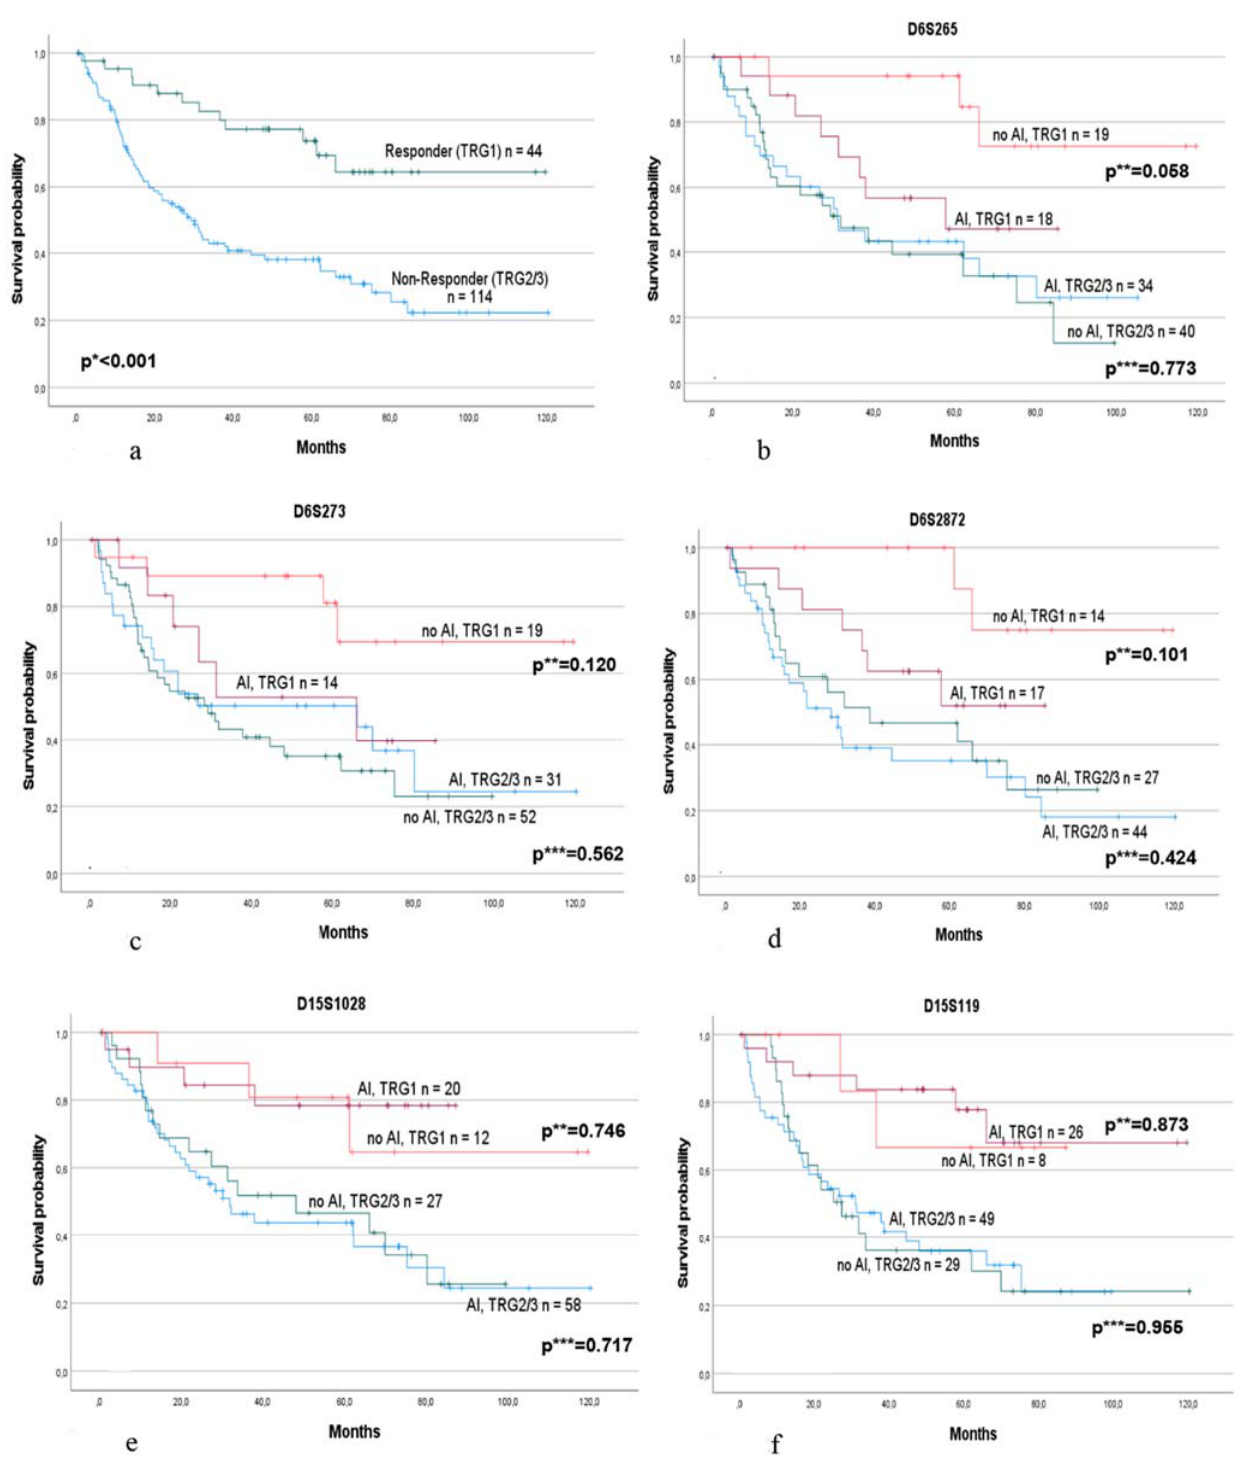
Figure 2. Survival of the responding and non ‐ responding patients alone and in association with AI at specific microsatellite markers of chromosome 6p21 and 15q21. Survival of ( a ) the responding (TRG1) and non ‐ responding (TRG2/3) patients. p * value log ‐ rank test. Survival in association with AI (allelic imbalance) or no AI in responding and non ‐ responding patients separately at marker ( b ) D6S265; ( c ) D6S273; ( d ) D6S2872; ( e ) D15S1028; and ( f ) D15S119. p ** values: univariable Cox regression for patients with AI and no AI in the responding group. p *** values: univariable Cox regression for patients with AI and no AI in the non ‐ responding group.